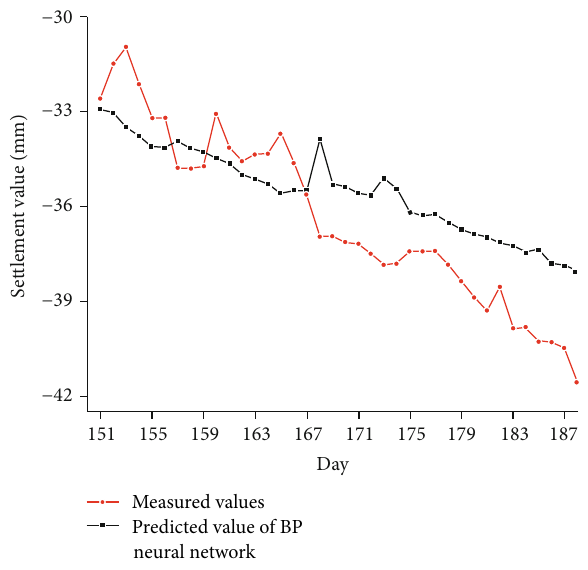
Figure 4: Comparison between measured values and predicted values of BP neural network.